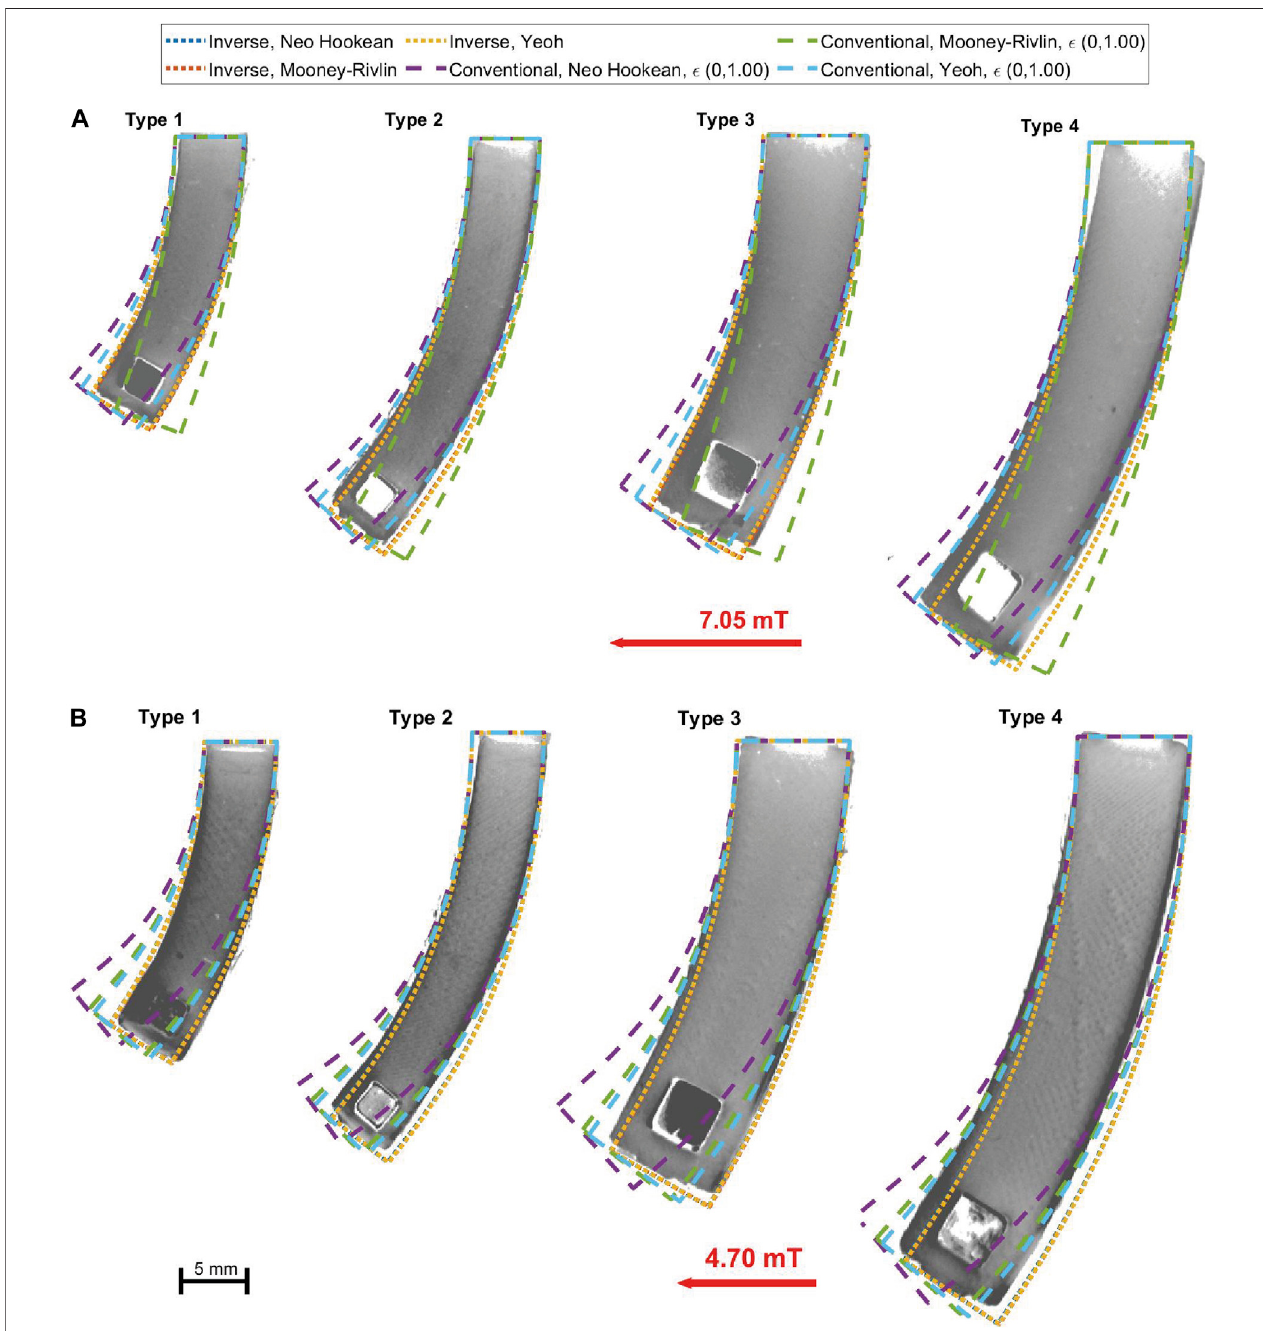
FIGURE 8 | Comparison between material models and experimental images for (A) Dragon Skin ™ 10 Medium samples under a magnetic fl ux density of 7.05 mT (top half) and (B) Eco fl ex ™ 00-50 samples under a magnetic fl ux density of 4.7 mT (bottom half).